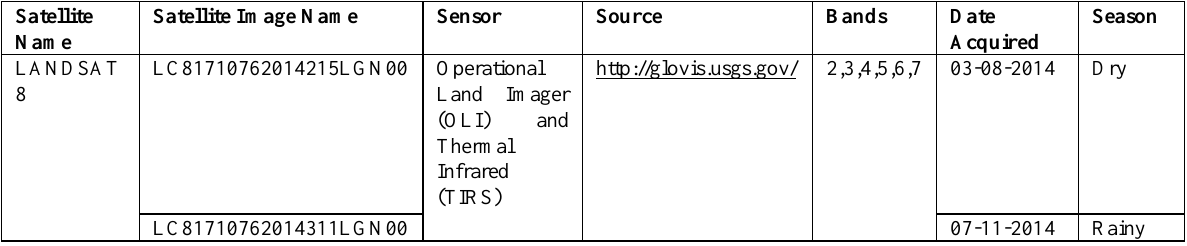
The 30 m spatial resolution LANDSAT 8 satellite data for the 2014 dry and rainy seasons were downloaded from the